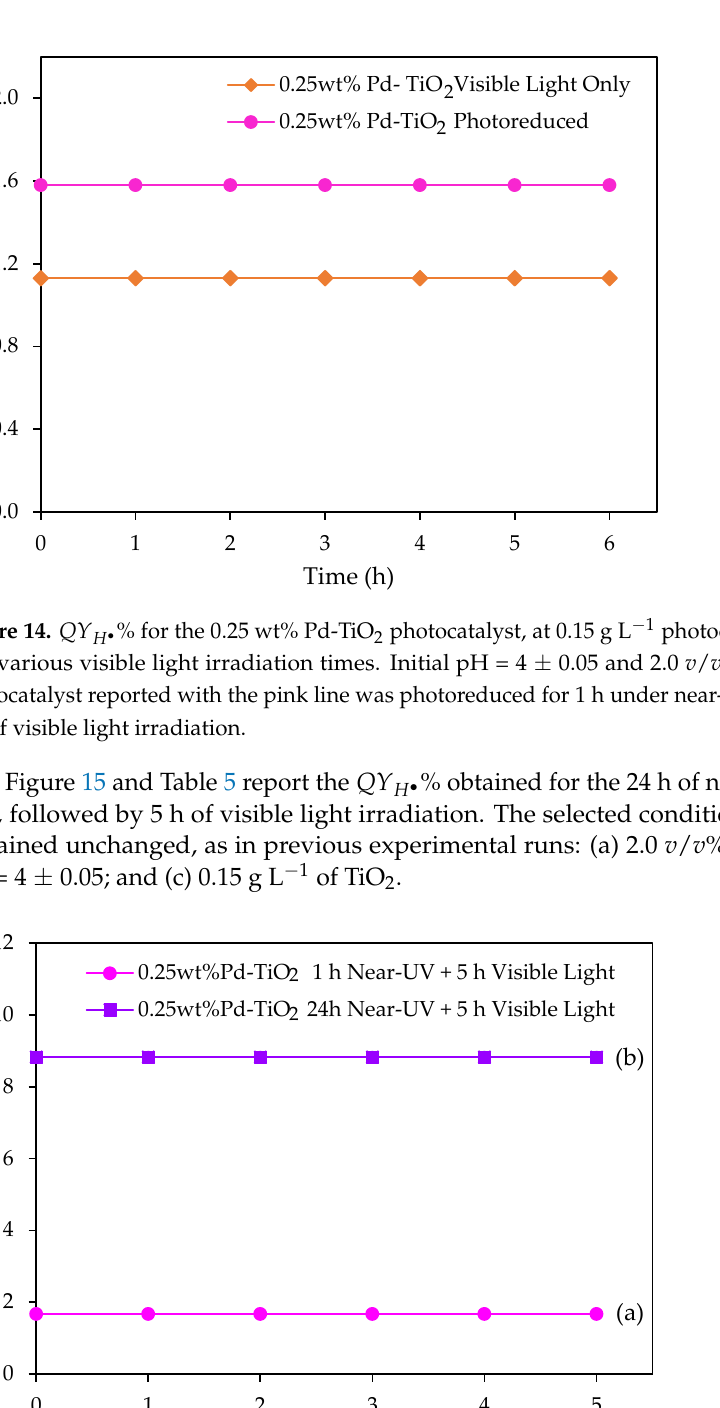
Figure 15. 𝑄𝑌 𝐻 • % at various visible light irradiation times: (a) 1 h of near-UV photoreduction, fol- lowed by 5 h of visible light irradiation; and (b) 24 h of near-UV photoreduction, followed by 5 h of